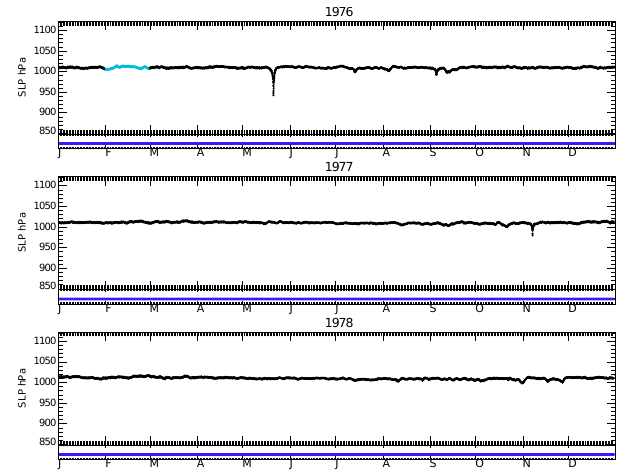
Fig. 14. Nearest neighbour data check (test 14) for 912180-99999 (13.57 ◦ N, 144.917 ◦ E, 162m, Andersen Air Force Base, Guam) for sea-level pressure. Red points show values removed by this test (none for the years shown) and blue points by other tests. The spikes for the hurricanes in 1976 and 1977 are kept in the dataset. February 1976 is removed by the variance check – this February has higher variance than expected when compared to all other Februaries for this